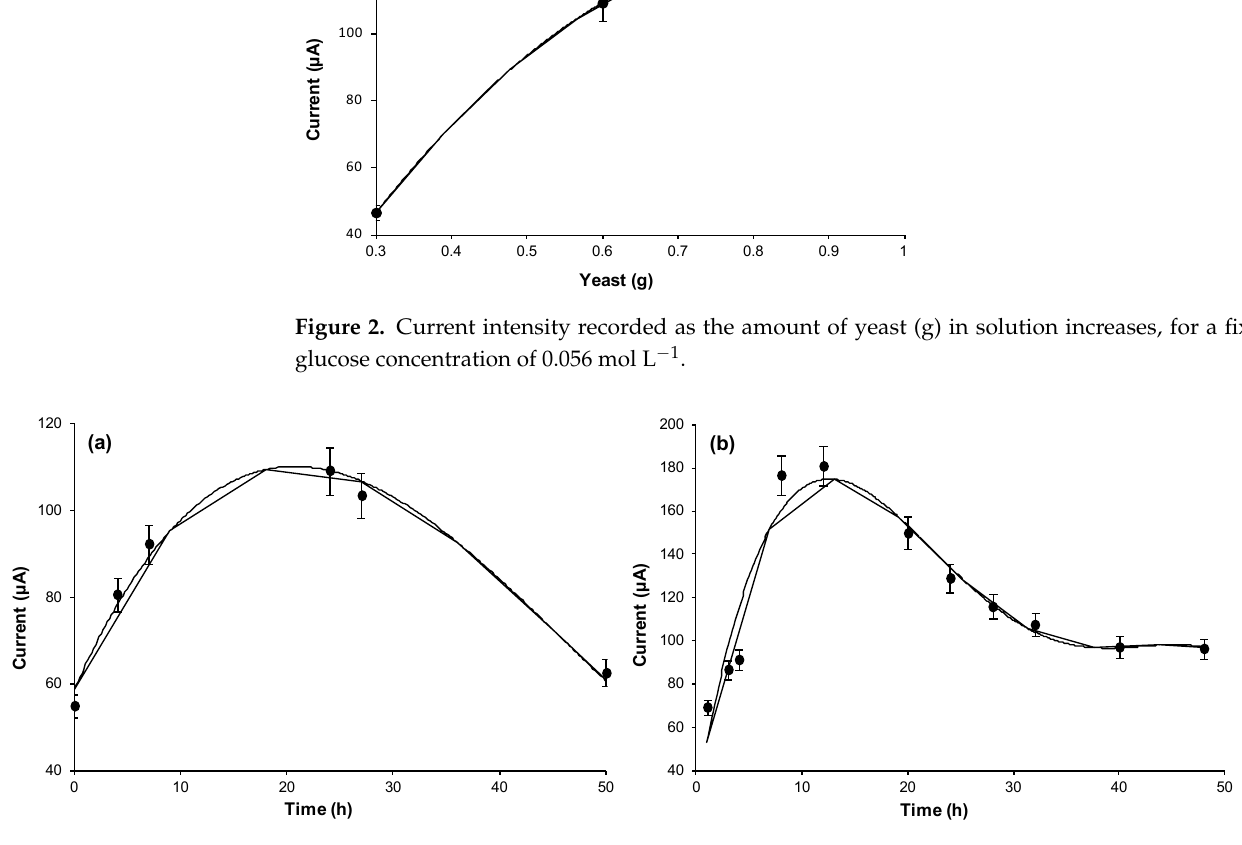
Figure 3. Current intensity recorded as a function of the contact time between yeast cells and glucose ( a ) operating at 25 °C; ( b ) operating at 28.5 °C. Yeast concentration: 0.6 g in 30 mL of aqueous glycine solution; glucose concentration 0.056 mol L −1 .